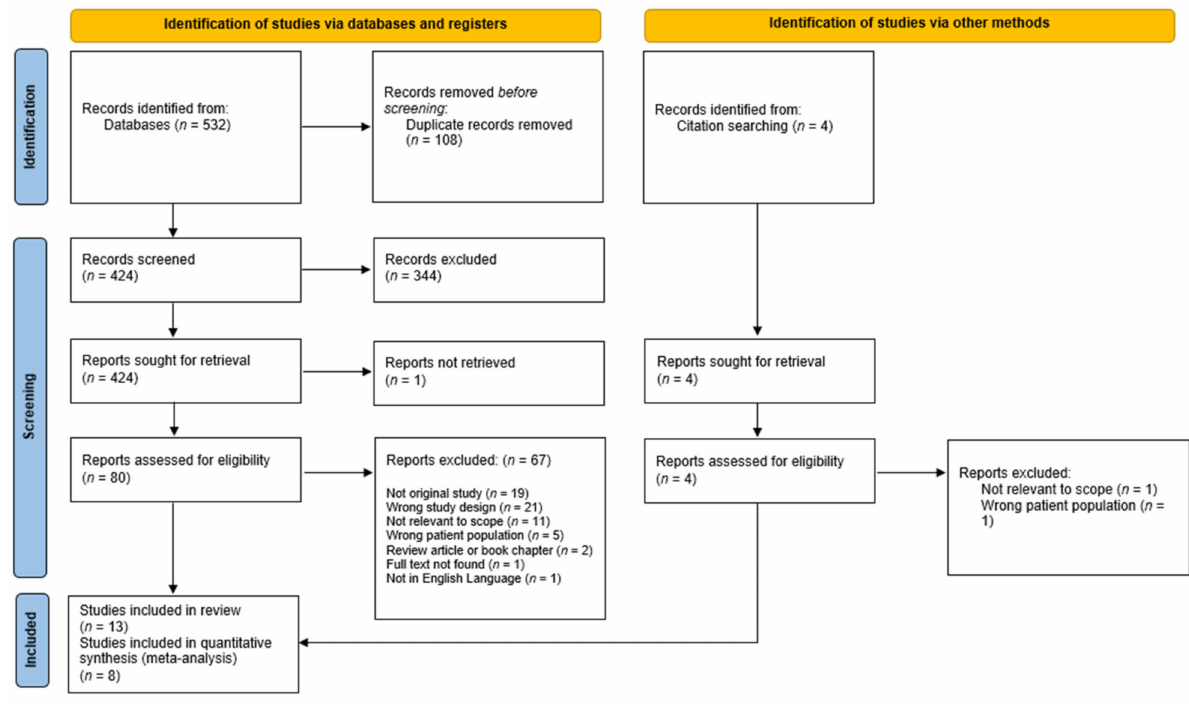
Figure 1. PRISMA flow chart of search